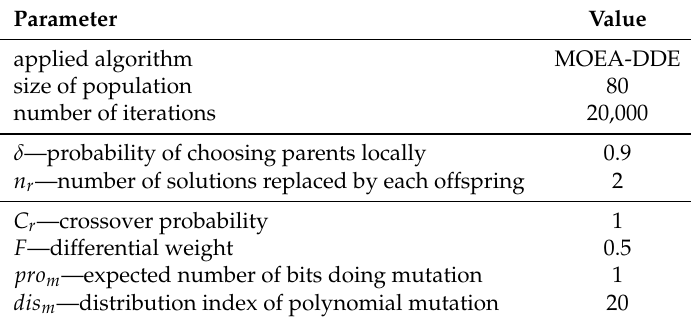
Table 3. Settings for MOEA/D-DE